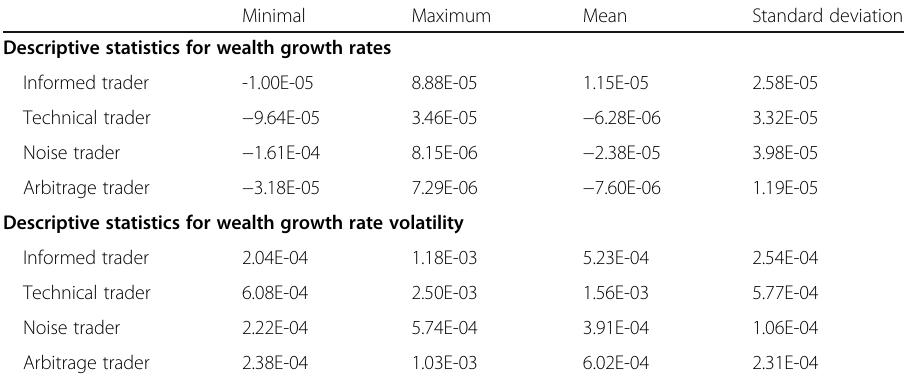
Table 2 Descriptive statistics for wealth growth rates and wealth growth rate volatility Minimal Maximum Mean Standard